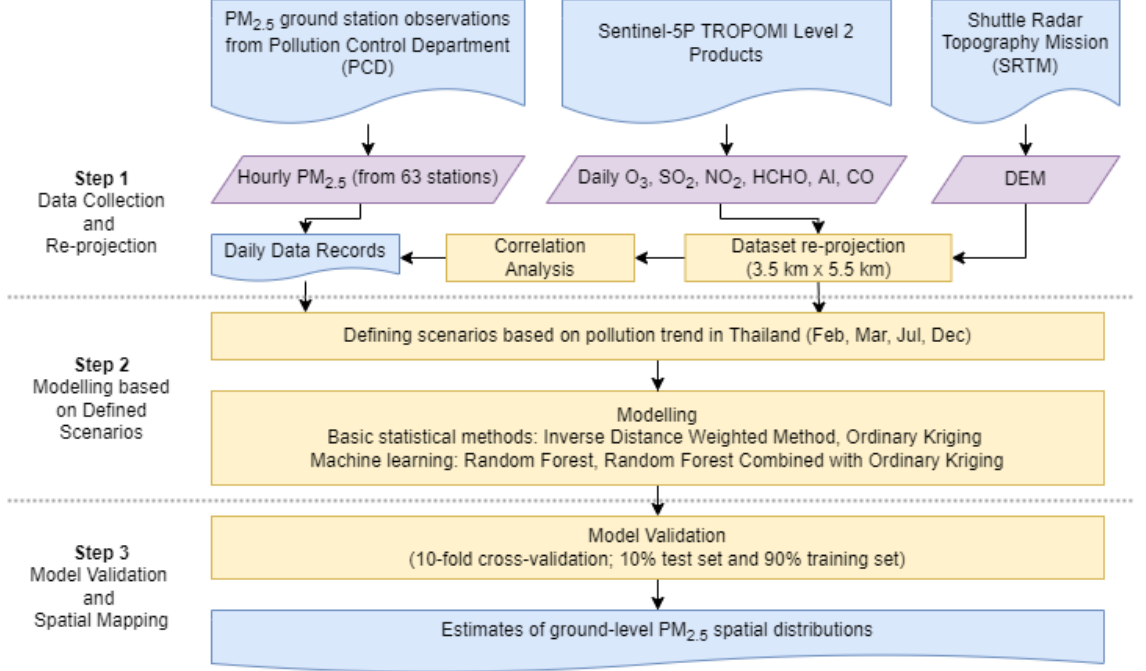
Figure 2. Processing workflow of PM 2 . 5 spatial interpolation via four models.